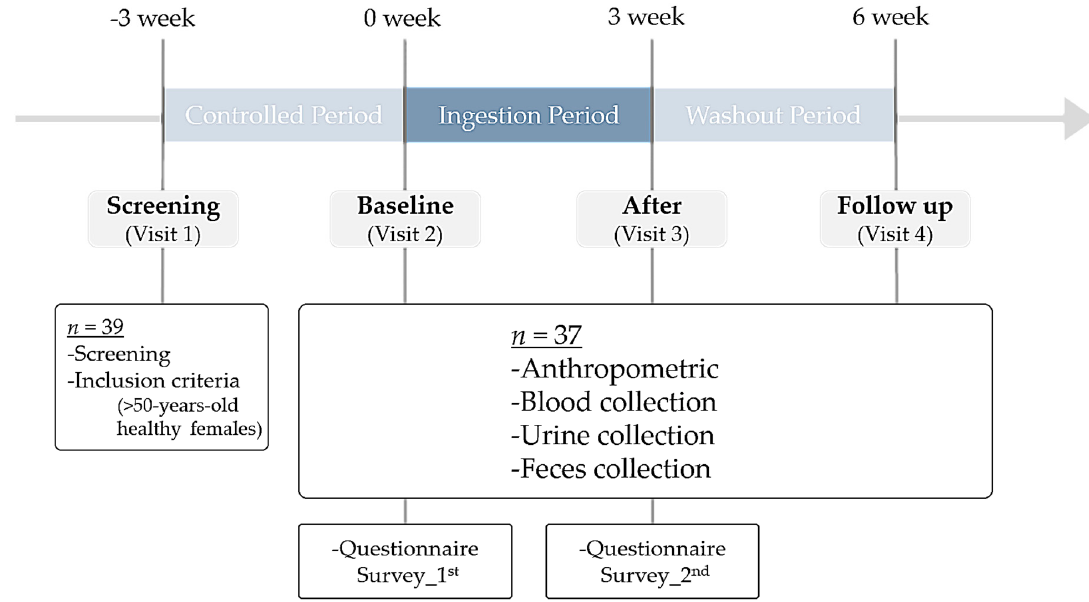
Figure 1. Study flowchart.